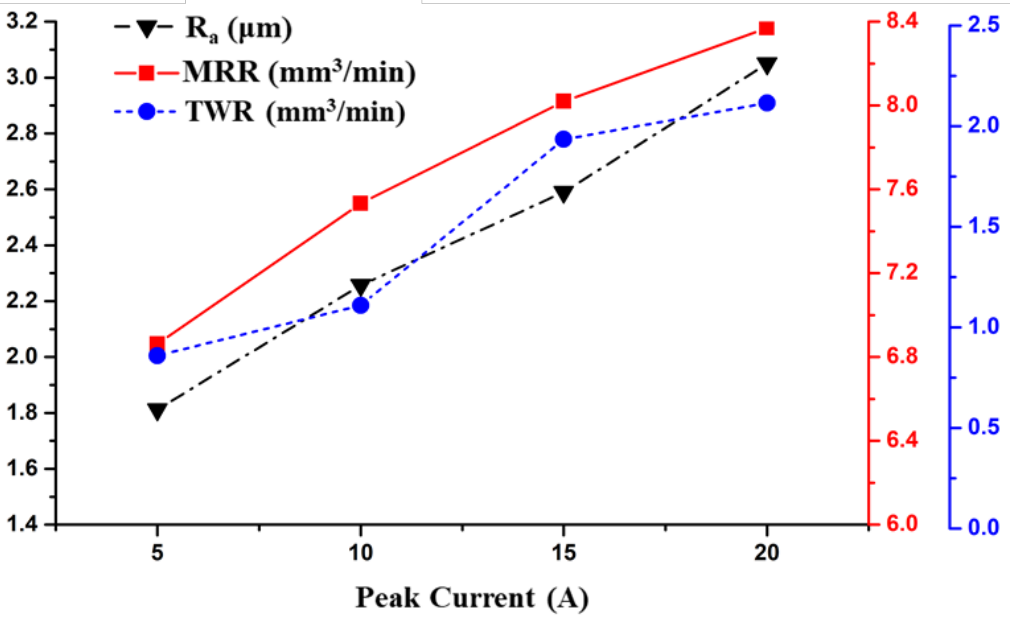
Figure 5. Effect of the Peak Current on the Responses.